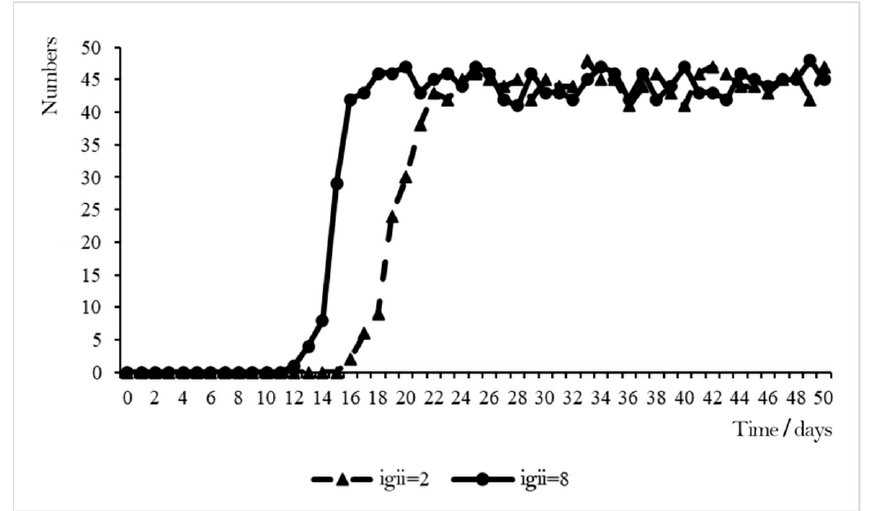
Figure 3. Effect of IGII on WSB.